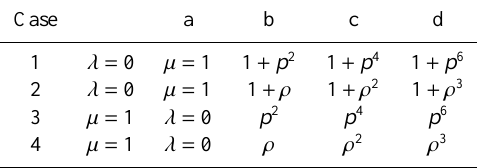
Table 1. Choices of parameters λ and µ for the sixteen cases.